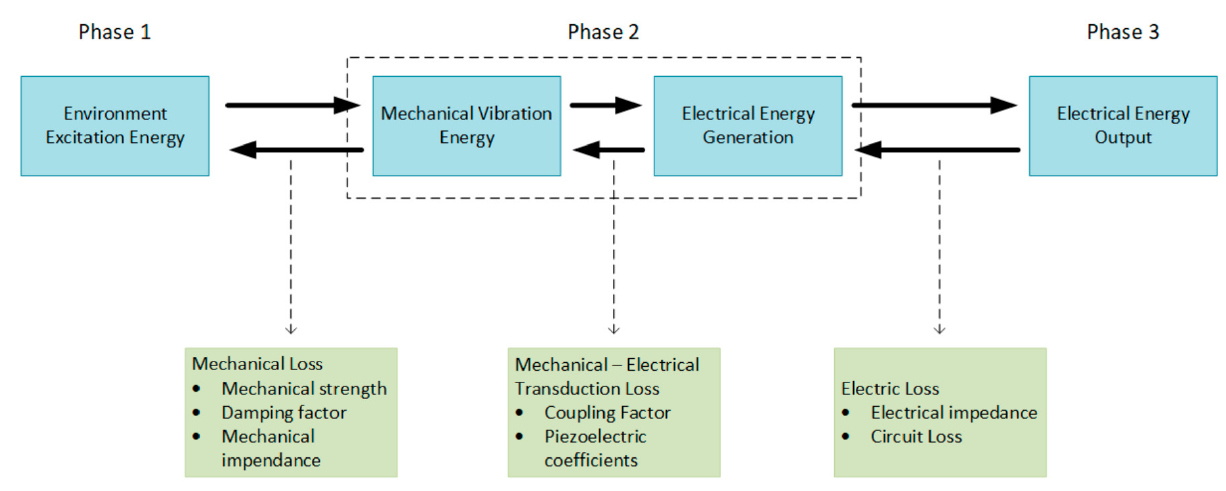
Figure 2. The Phases of the Piezoelectric Energy Harvesting Process. 1